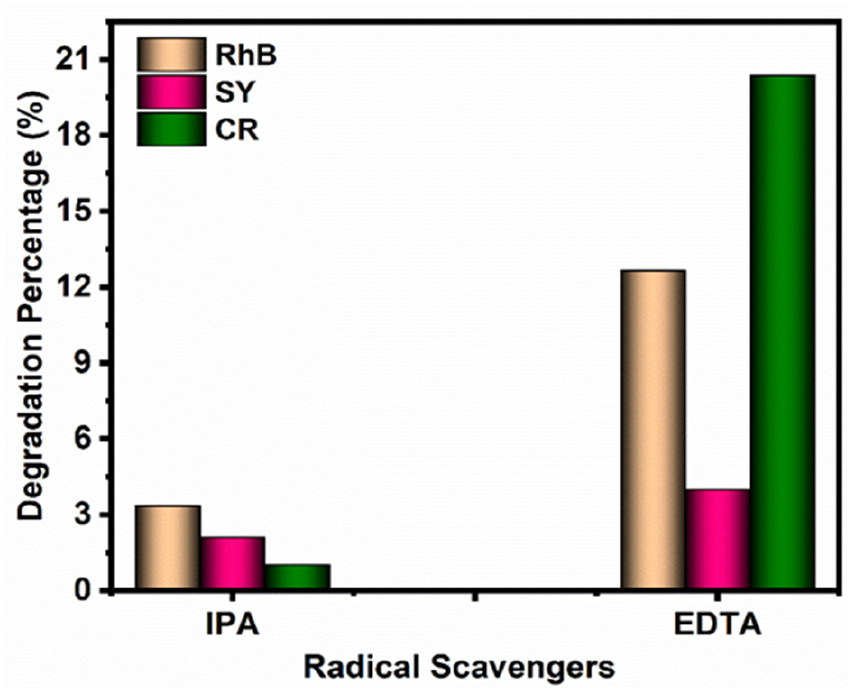
Figure 8. Degradation efficiency of radical scavengers’ experiment.